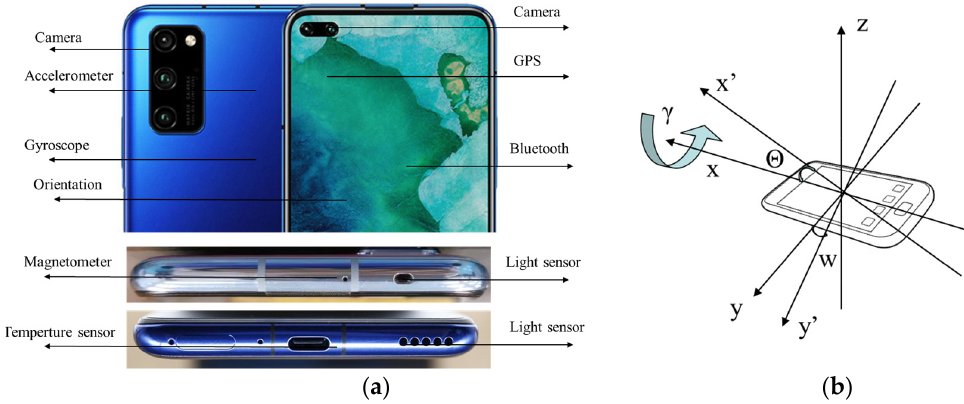
Figure 7. ( a ) Sensors included in the phone; ( b ) schematic diagram of the direction sensor.